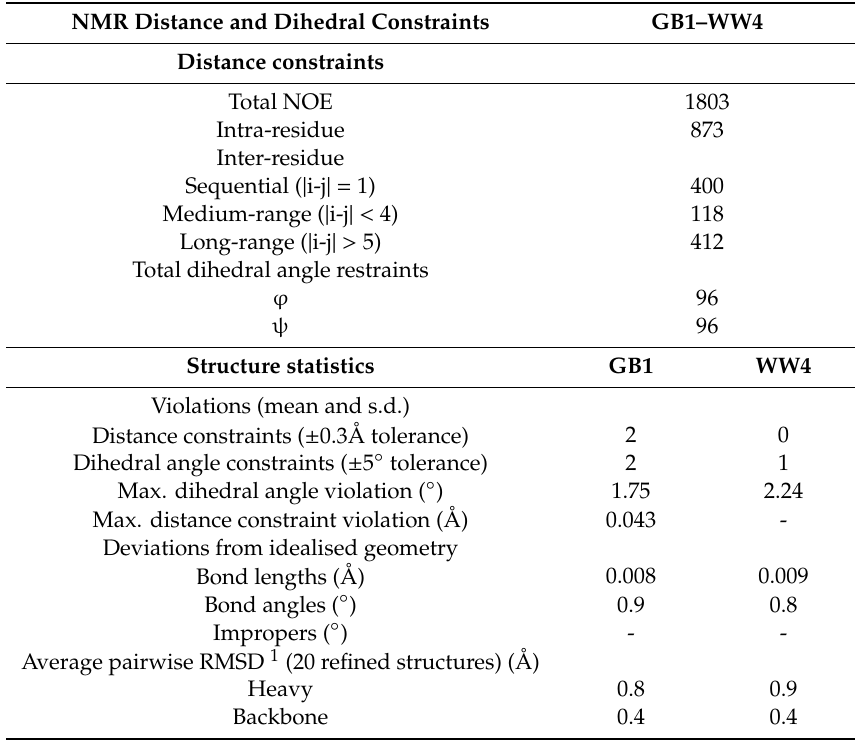
Table 1. Summary of the NMR data and structure validation statistics for each domain. NMR Distance and Dihedral Constraints GB1–WW4